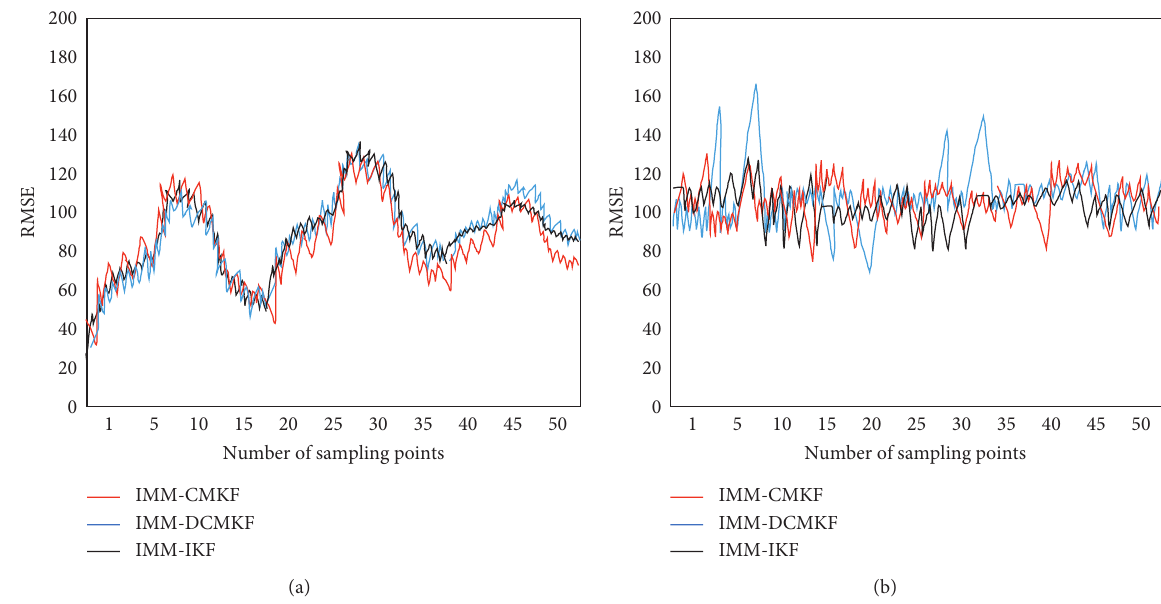
Figure 6: Comparison of the root mean square error of position in the X and Y directions on the CA model. (a) Root mean square error of position in x direction. (b) RMSE of position in y